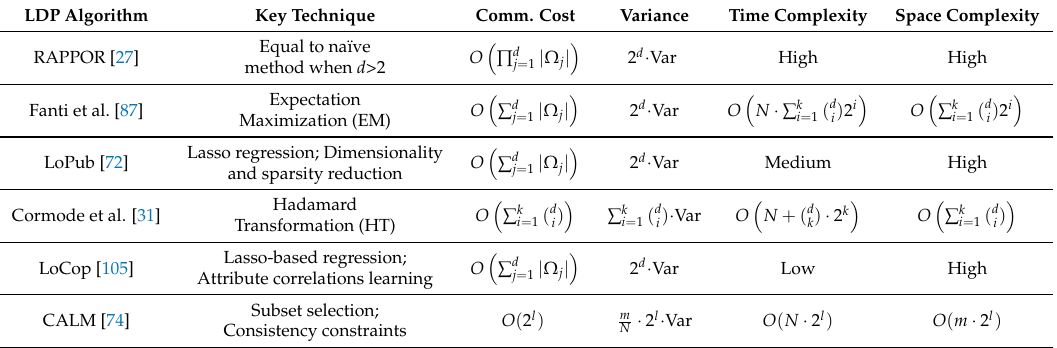
Table 8. Comparisons of LDP-based algorithms for k -way marginal release of d -dimensional data. LDP